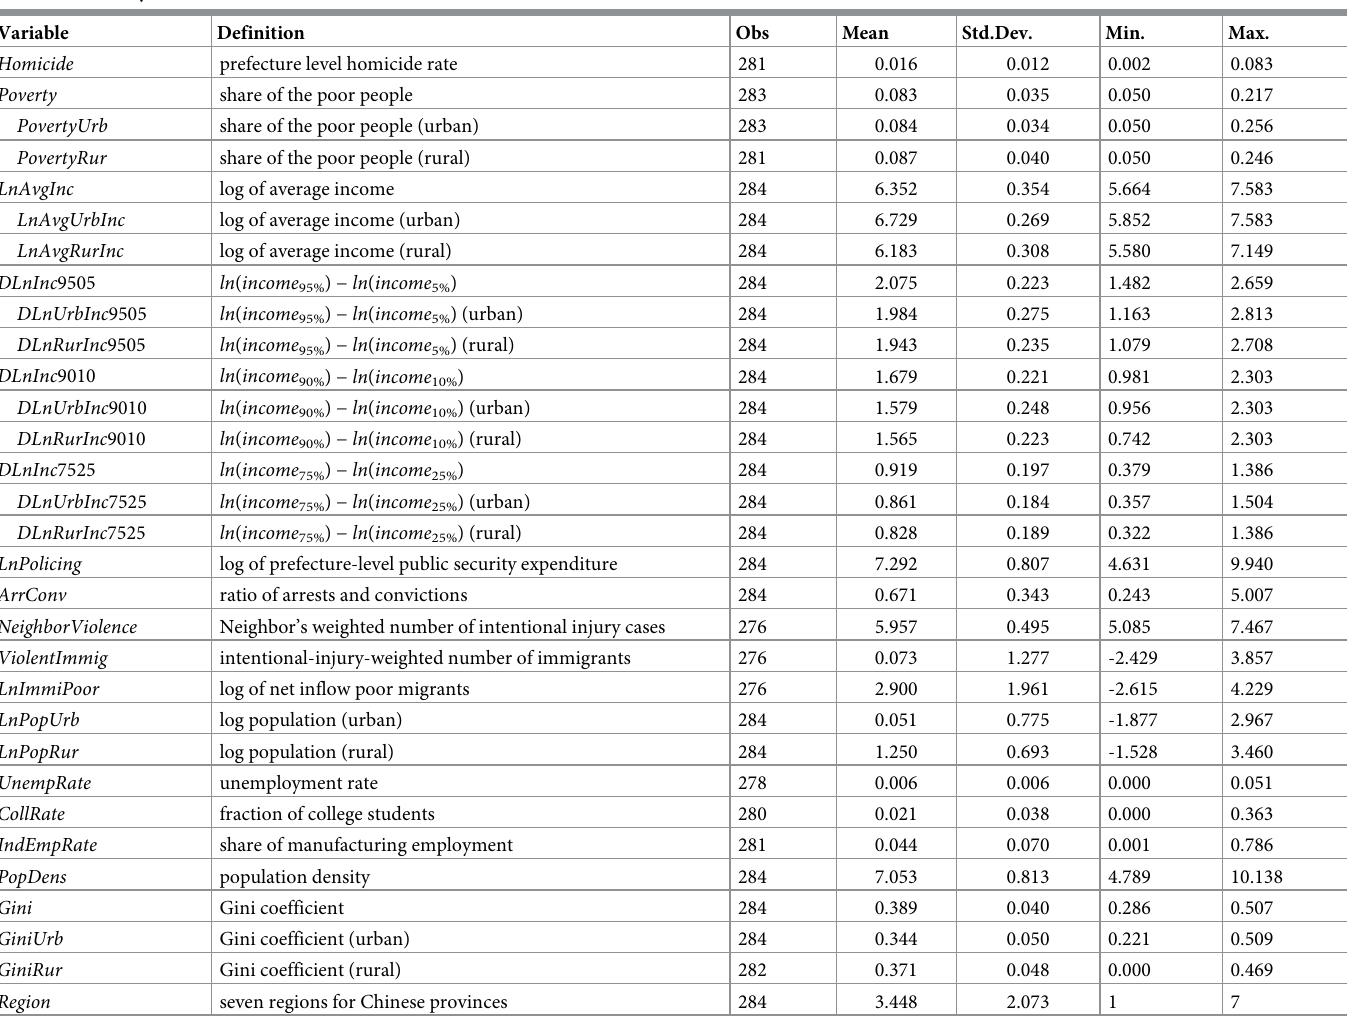
Table 1. Summary